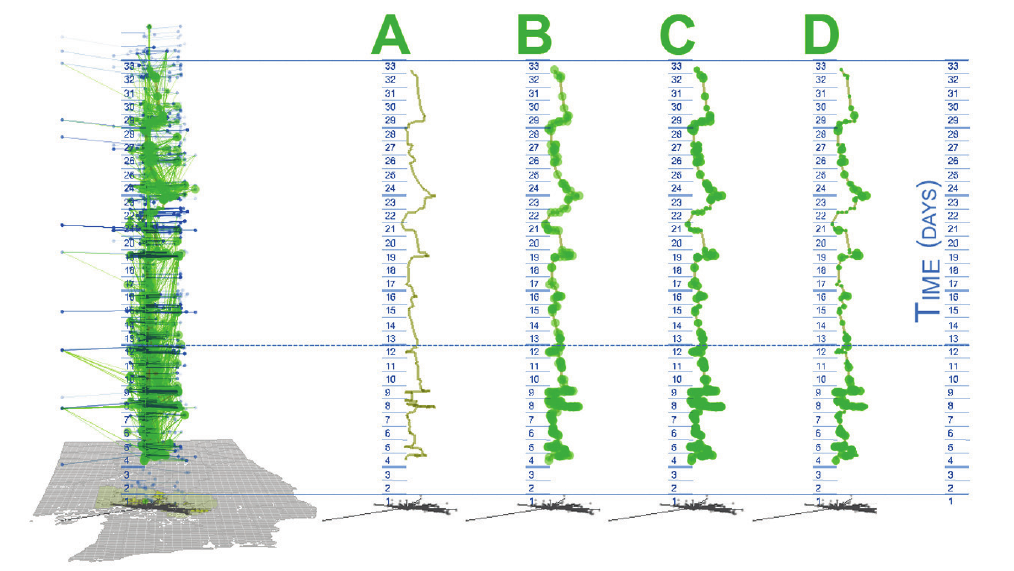
Figure 7: The static display of the grapevine. A main stem grows up with the increasing number of messages over geographical space. The main stem generates nodes when the number of votes to messages increases. The nodes generate buds when the number of replies (thus social connections) to messages increases. It shows the main stem in four states: (A) all features are turned off; (B) nodes are turned on; (C) the number of nodes is according to the number of votes; (D) the size of buds is according to the number of replies. Reproduced from Figure 4 in